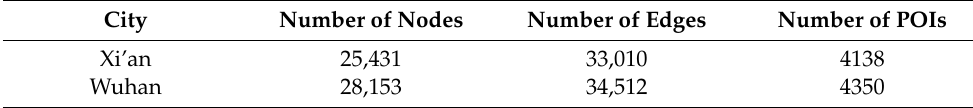
Table 2. Introduction to other data.